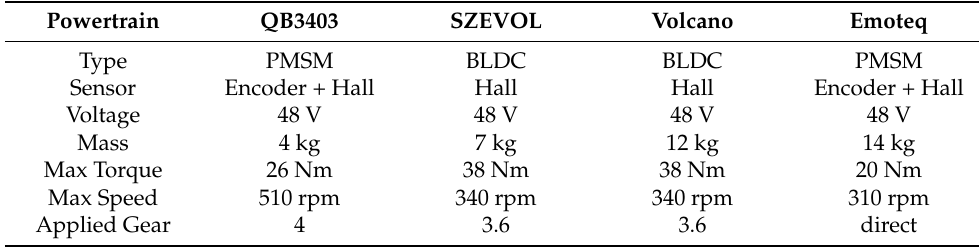
Table 2. The properties of the applicable